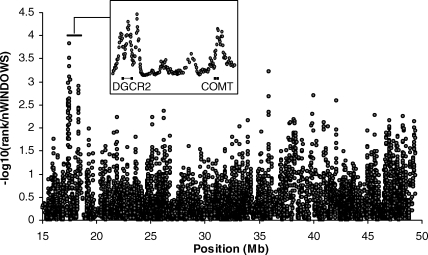
Association Signal on Chromosome 22 in a Sliding-window of Nine Consecutive SNPsThe −log10 values are the negative logarithm (base 10) of the sliding windows ranks divided by the number of windows on Chromosome 22. The combined rank across men and women is based on a silhouette statistic [36]. The inset shows a magnification of the region indicated by a vertical line and the position of DGCR2 and COMT genes within this interval.